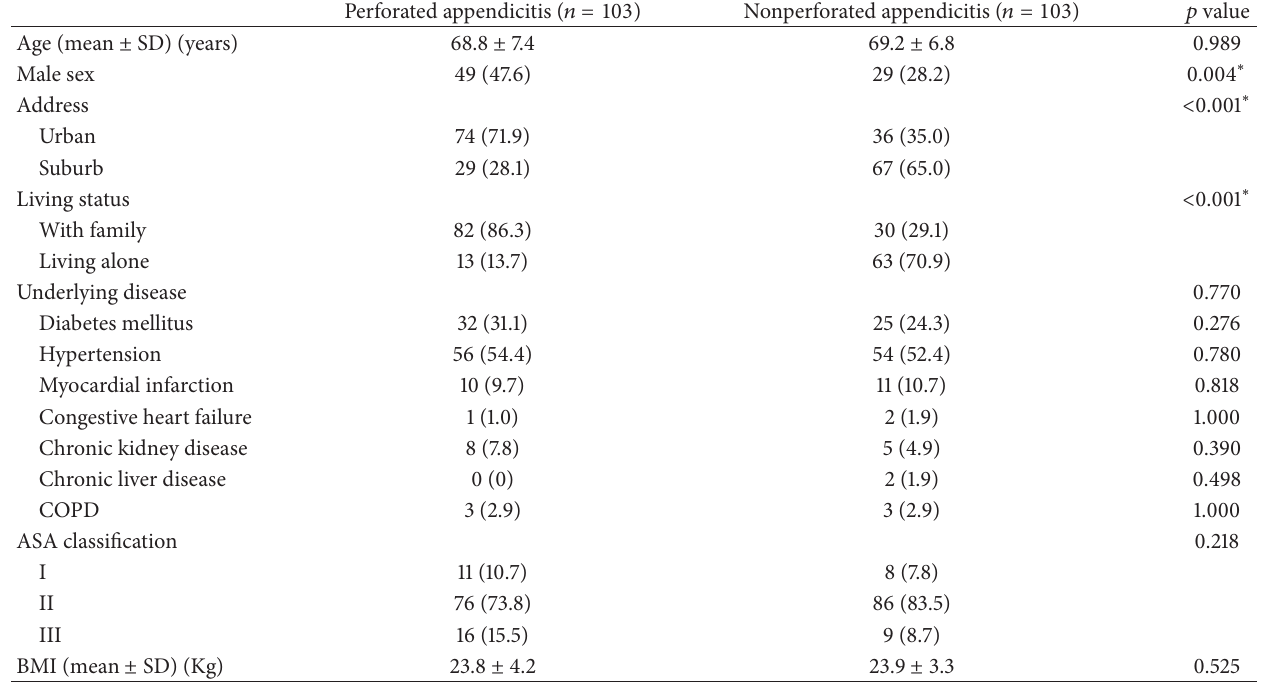
Table 1: Comparison of patients’ characteristics in the perforated and nonperforated appendicitis